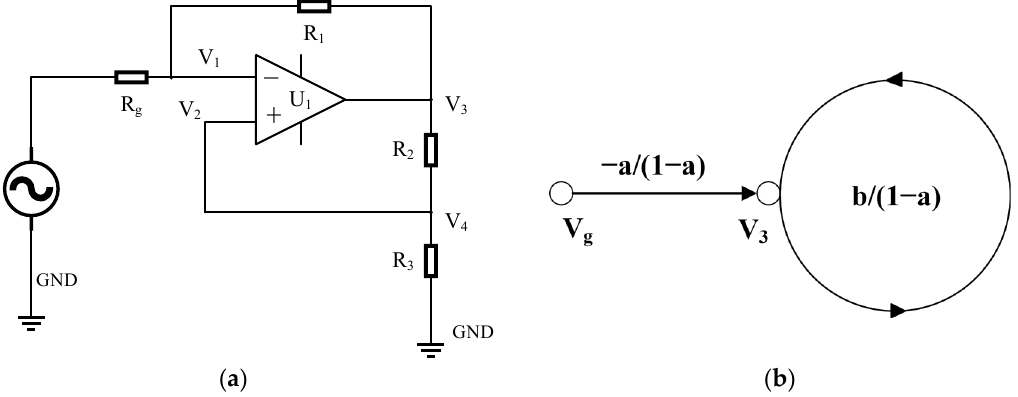
Figure 2. ( a ) Negative impedance inverter circuit of the sensor; ( b ) its directed graph. R g is the ohmic resistance of geophone coils.